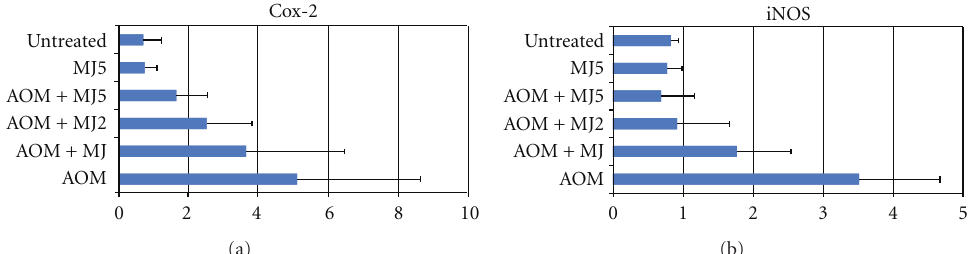
Figure 10: MJs suppress mRNA expression of inflammatory enzymes, Cox-2 and iNOS, in the colonic mucosa of rats that received AOM at week 4 of the study.